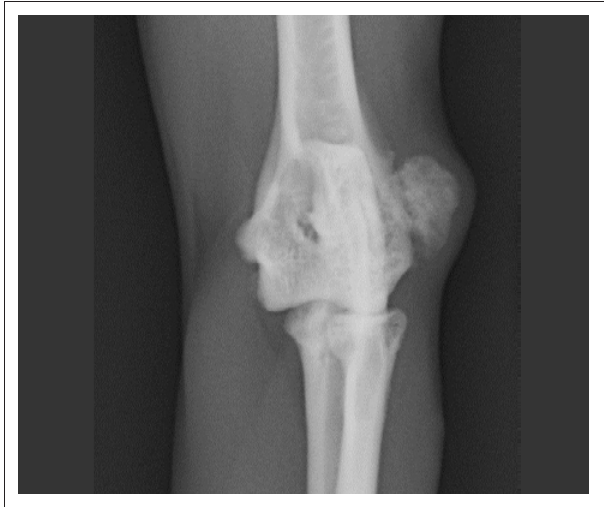
FIGURE 4: Craniocaudal view of the left elbow of a cat positive for feline leukaemia virus five months after initial presentation, showing local re- growth of the osteochondroma. Note the presence of the same radiographic characteristics as the initial